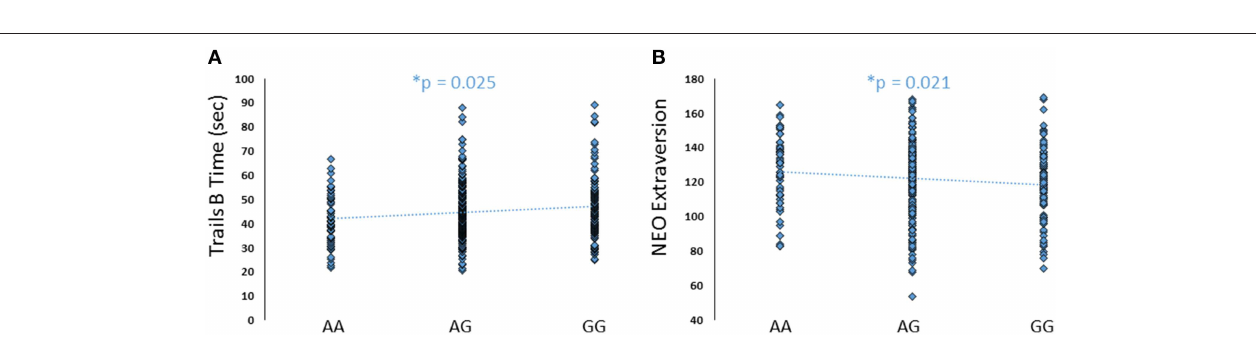
FIGURE 7 | Effects of FREM3 rs1909022 genotype on TMT Part B performance and extraversion. Increasing number of major (G) alleles was associated with relatively slower TMT performance (A) and lower levels of extraversion (B) . * p < 0 . 05